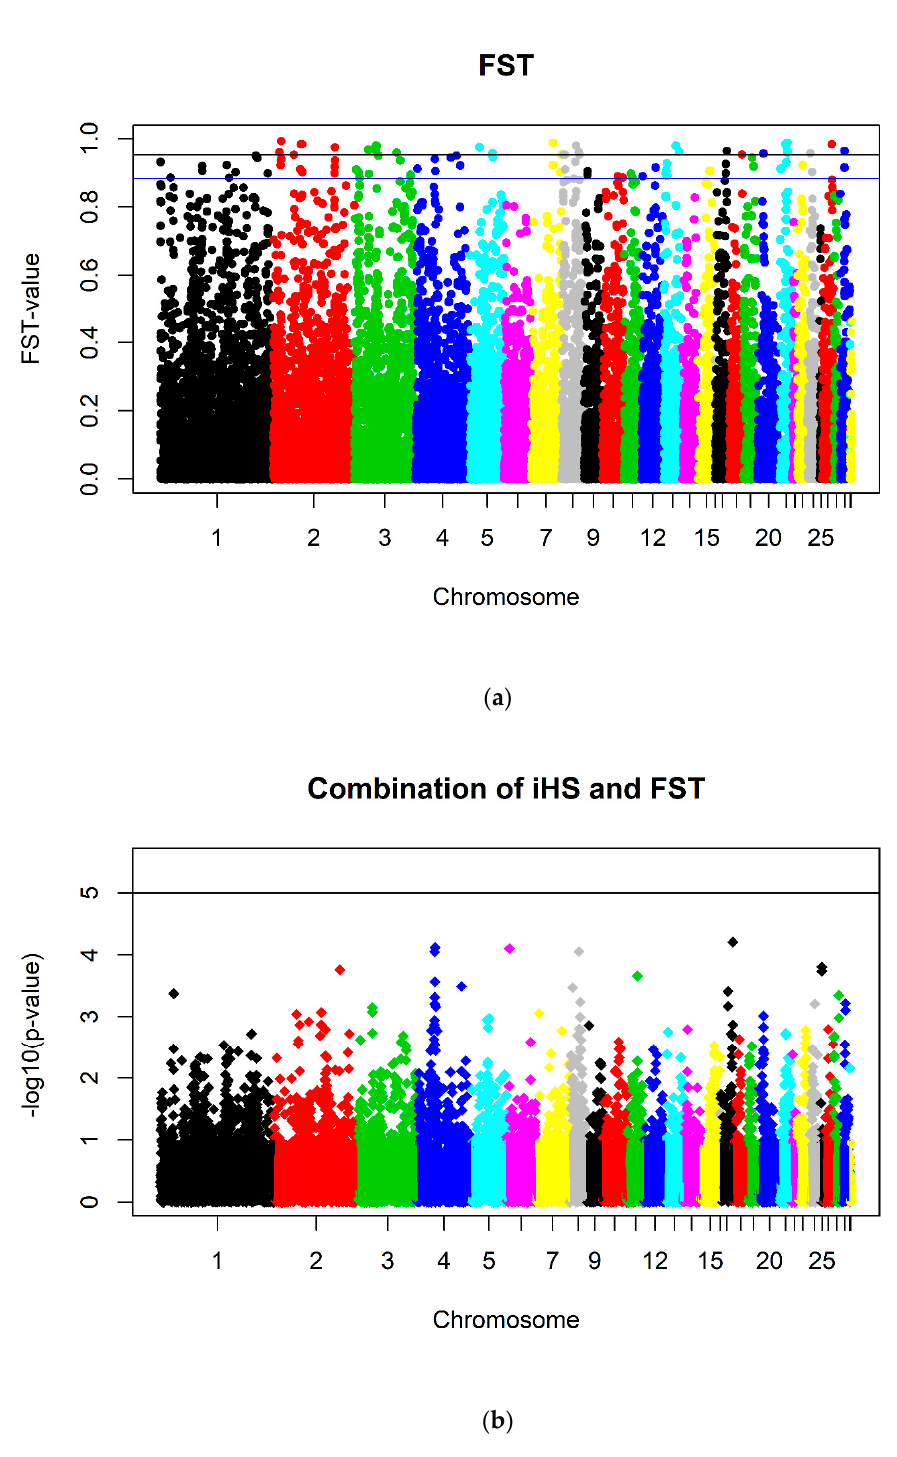
Figure 4. ( a ) Manhattan plot of F ST -indices (n SNP = 29,020). The top line indicates the nominal level of significance p nominal ≤ 5 × 10 − 5 and the bottom line the nominal level of significance p nominal ≤ 5 × 10 − 4 . ( b ) Manhattan plot of the − log 10 p -values of the combination of the combined iHS p -values and the F ST p- values (n SNP = 16,766). The line indicates the nominal level of significance p ≤ 10 − 5 . The meta-analysis of the combination of the p -values of the combined iHS statistic and the F ST indices is plotted in Figure 4. No SNPs reached significance.